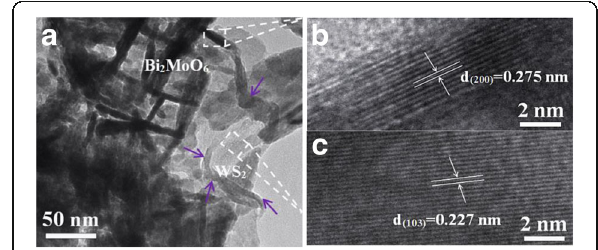
Fig. 3 TEM ( a ) and HRTEM ( b , c ) images of WS 2 /Bi 2 MoO 6 (5 wt%)